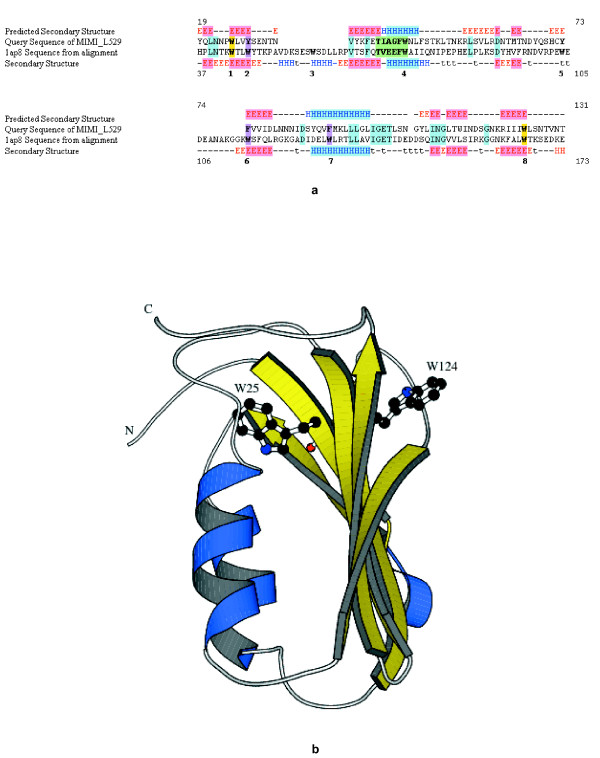
a) Sequence-structure alignment ORFan L529 and yeast translation initiation factor (PDB code: 1ap8). The eight conserved tryptophans of 1ap8 are numbered as 1–8. The conserved terminal tryptophans (Trp-1 & Trp-8) are shown in yellow boxes. The consensus motif (S/T)VxxxFW is highlighted in green color. b) Ribbon diagram of predicted model of ORFan L529. The model was built from FFAS03 [55] and refined using Nest [53]. The model shows curved antiparallel β-sheet with two long helices present on one side. The conserved tryptophan residues (Trp25 and Trp124) required for cap recognition are shown in ball-and-sticks.